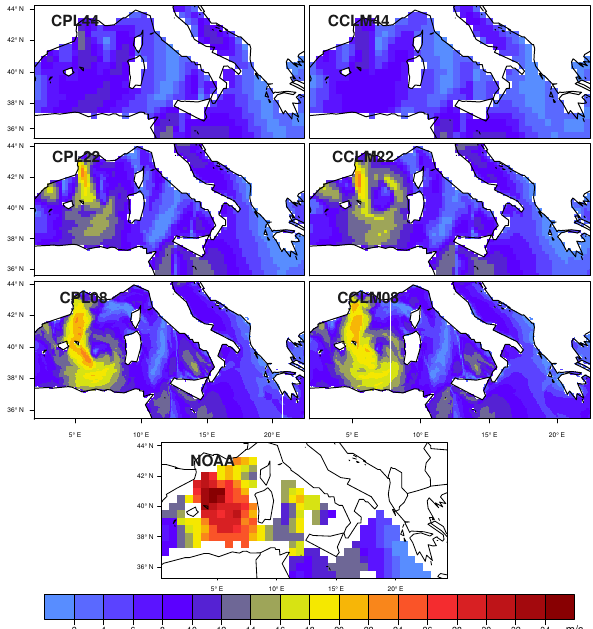
Figure 3. ME08; 10m wind speed (ms − 1 ) in the coupled and atmosphere-only (0.44, 0.22, and 0 . 08 ◦ ) simulations and the NOAA “Blended Sea Winds” on 7 October 1996 at